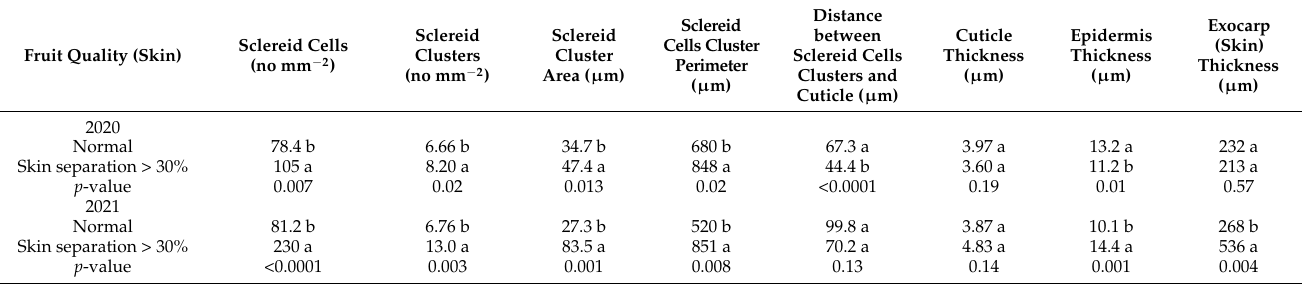
Table 2. Anatomical changes in date palm fruit ‘Mejhoul’ at the Tamr stage, September 2020 and 2021.